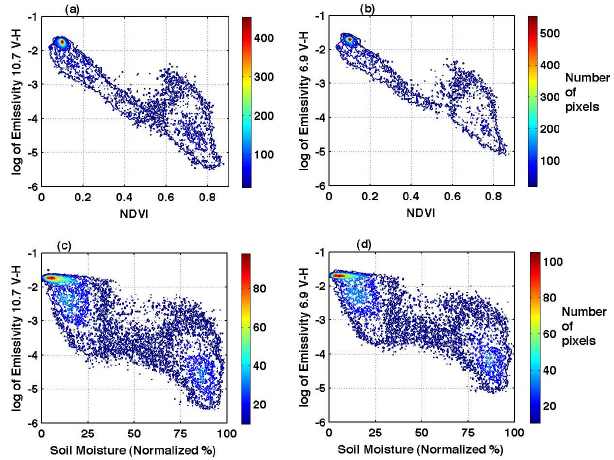
Fig. 5. (a–b) Scatter plot of logarithm of emissivity polarization dif- ference at 10.7GHz and 6.9GHz (V-H) versus NDVI. (c–d) Scatter plot of logarithm of emissivity polarization difference at 10.7GHz and 6.9GHz (V-H) versus ASCAT soil moisture.